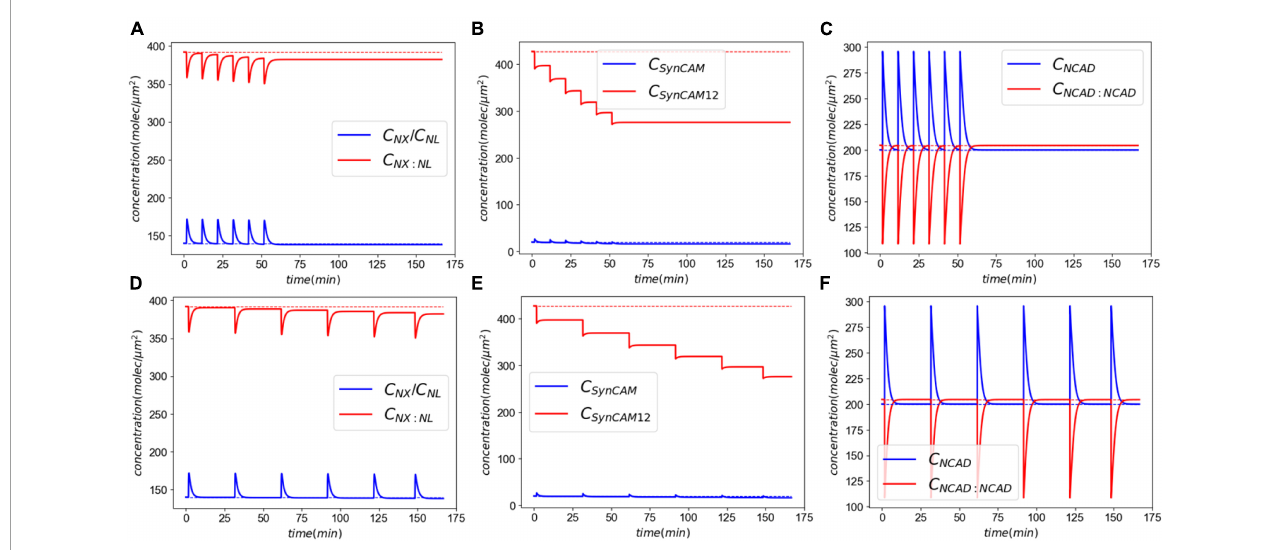
FIGURE7 Molecular response to exposure to repeated LLBs. Panels (A–C) show the response to six insults every 10 min. Panels (D–F) show the response to six insults every 30 min.